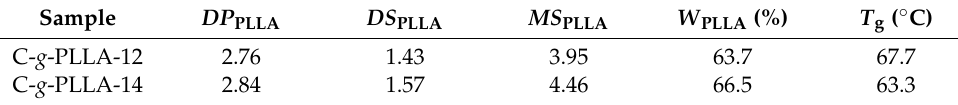
Table 1. Chemical structure and glass transition temperature of C- g -PLLA.